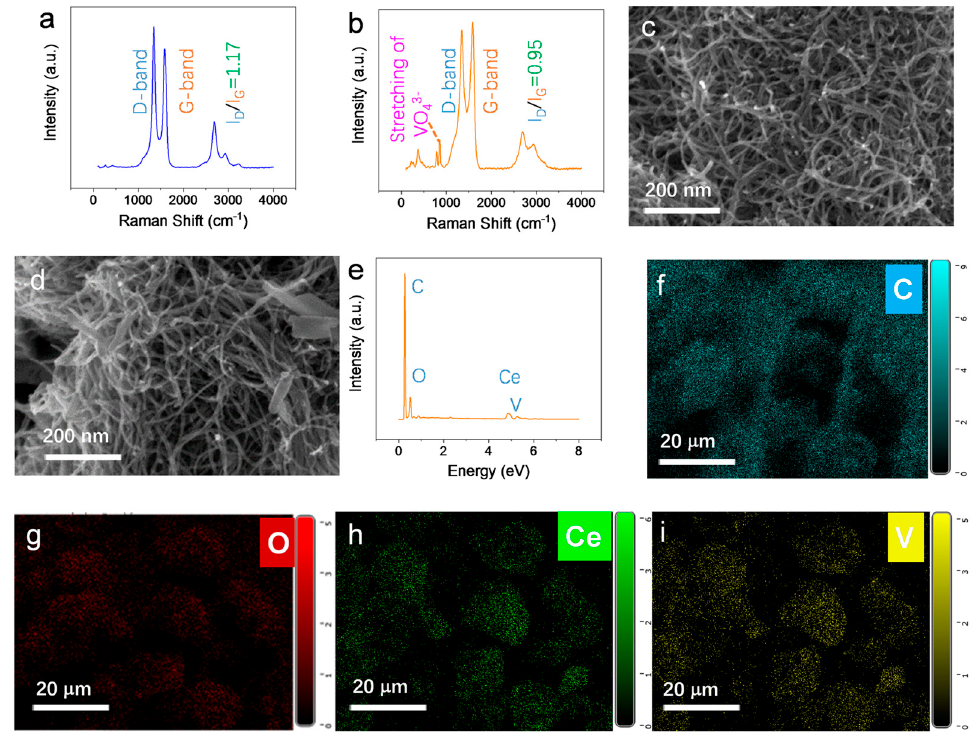
Figure 1. Raman spectra of ( a ) MWCNTs and ( b ) CeVO 4 /MWCNTs. SEM images of ( c ) MWCNTs and ( d ) CeVO 4 /MWCNTs. ( e ) EDS spectrum of CeVO 4 /MWCNTs. ( f – i ) EDX mapping of CeVO 4 /MWCNTs showing the distribution of C, O, Ce, and V.